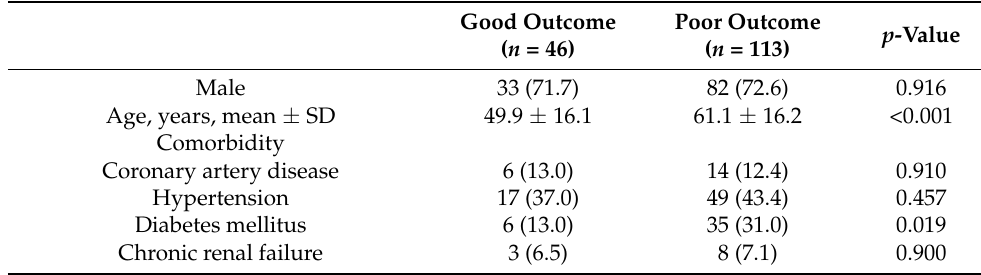
Table 1. Baseline characteristics of the included